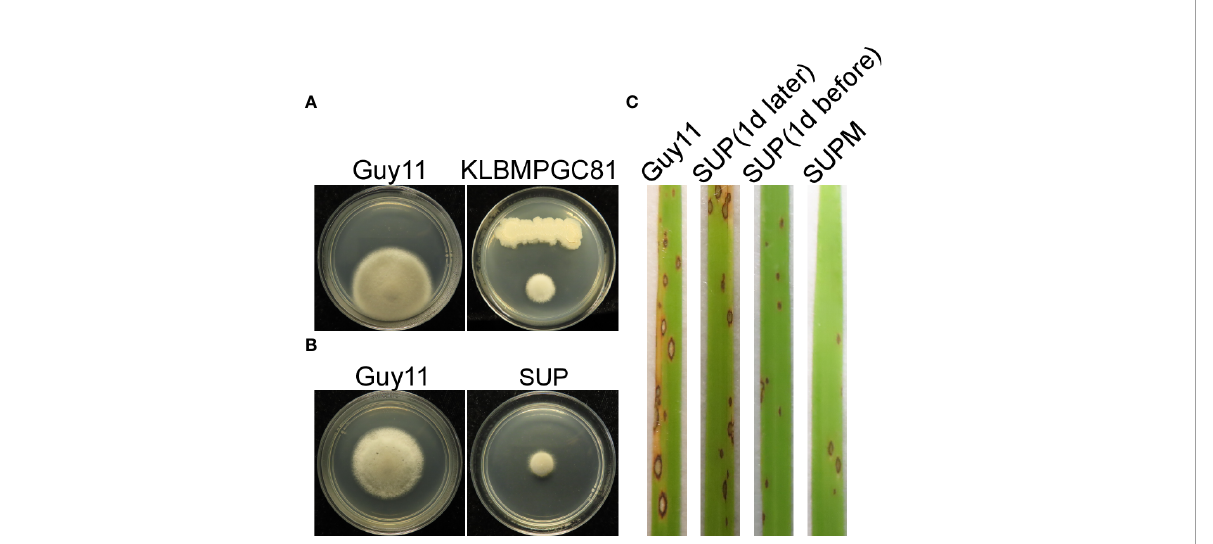
FIGURE 1 Biocontrol of M. oryzae using B subtilis KC81. (A) Cultured strains Guy11 on CM plates with B subtilis KC81. (B) Cultured strains Guy11 on CM plates with KC81 SUP. (C) Leaves showing blast symptoms in the presence of KC81 SUP. All rice seedlings were treated with strain Guy11. Guy11: M. oryzae ; SUP: cell-free culture supernatants of strain KC81; SUP (1 day later) and SUP (1 day before): SUP sprayed onto rice seedlings 1 day after or 1 day before the strain Guy11 spray treatments, respectively; SUPM: rice seedlings sprayed with strain Guy11 mixed with